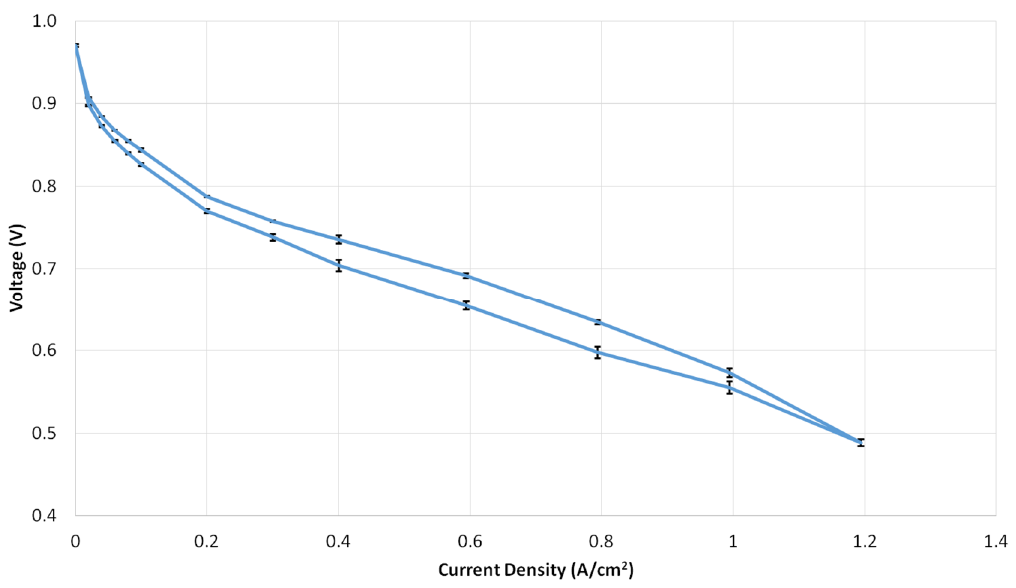
Figure 3. Polarization curve for reference conditions. Forward curve (increasing current) in the bottom; Backward curve (decreasing current) at the top. Error bars corresponding to three repetitions are included for each measurement point.